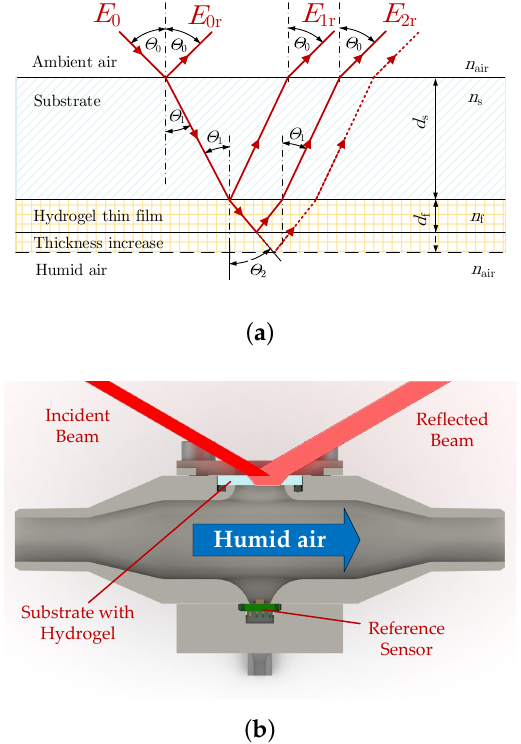
Figure 2. ( a ) Principal sketch of a field that gets reflected at a swelling hydrogel thin-film layer deposited on a substrate (thickness of the hydrogel is drawn exaggerated); and ( b ) sectional view of the practical implementation of the substrate with the hydrogel (drawn in light blue) at the measurement chamber. Reference sensor (in green) on the opposite